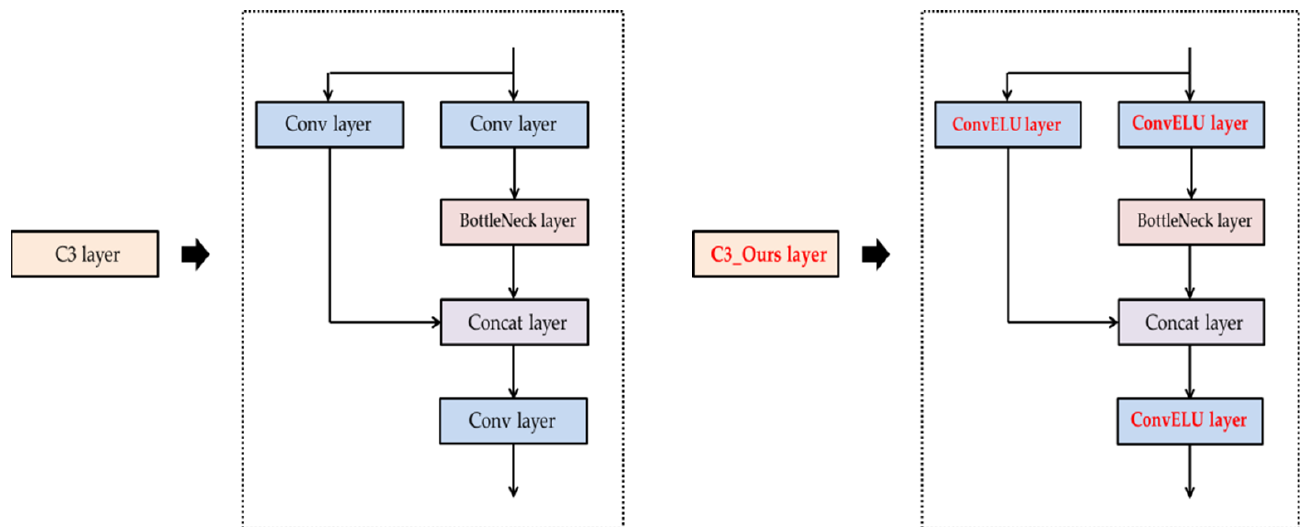
Figure 3. Comparison of Conv and Conv_Ours layer ( Left figure is the existing layer, Right figure is the way we suggest it).